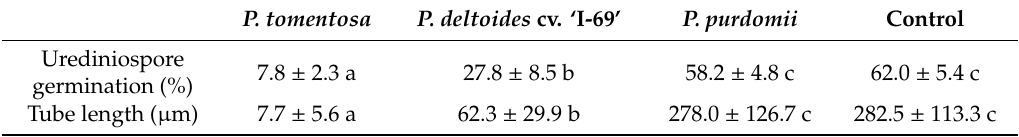
Table 1. Germination rates and germ tube lengths of urediniospores in cuticle extracts.